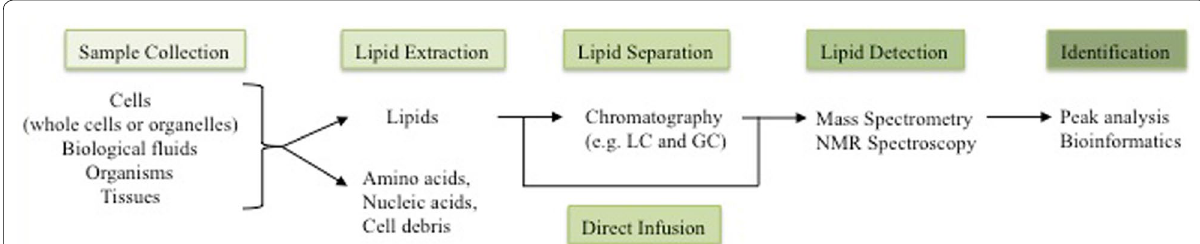
Fig. 1 Workflows of lipidomics. Lipids are extracted in organic solvents from various samples. Extracted lipids are either further separated by a chromatography or directly infused to mass‑spectrometry. Peak analysis identified lipid